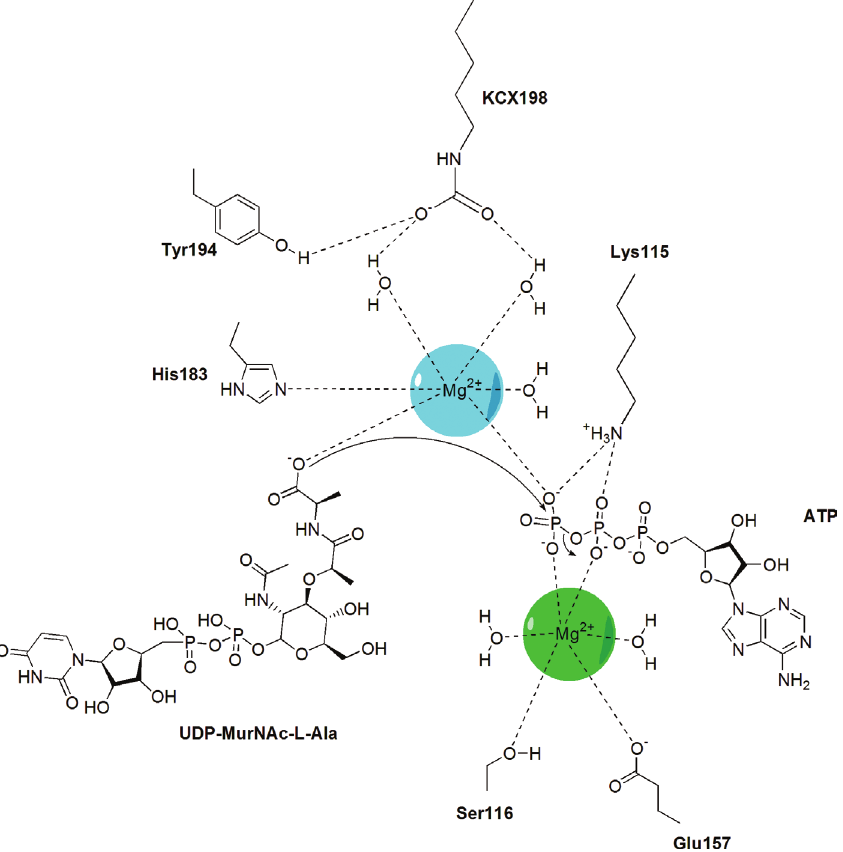
Table 1. In almost all cases, K